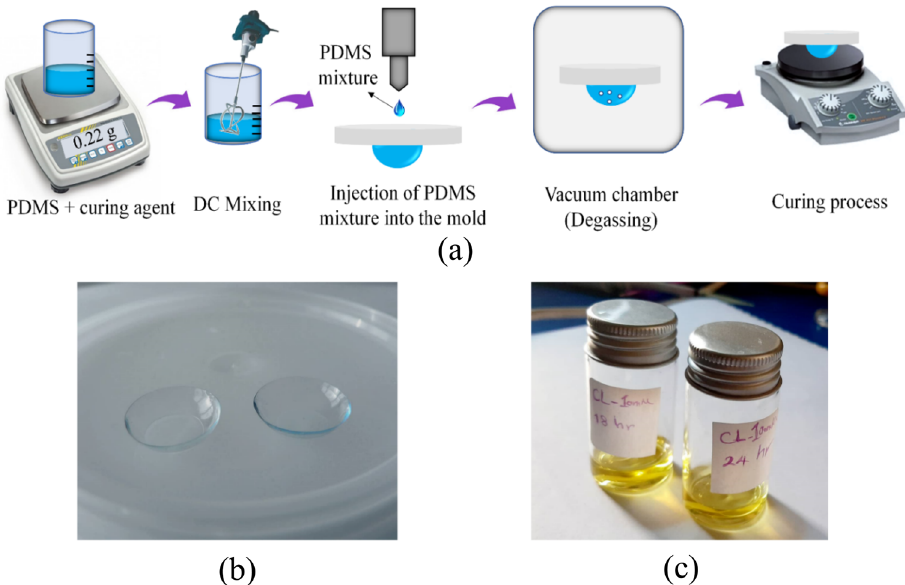
Figure 1. ( a ) A schematic array of the fabrication process of the proposed PDMS-based lenses, ( b ) the image of the fabricated PDMS-based lenses, and ( c ) immersing the PDMS-based lenses into HAuCl 4 ·3H 2 O gold solution for different incubation